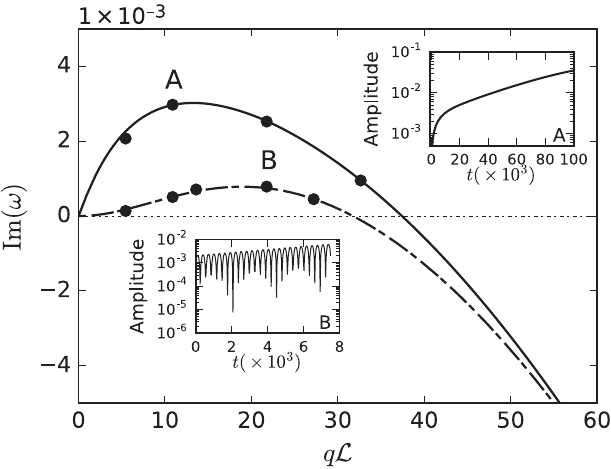
FIG. 3. Comparison of the growth rates obtained from dispersion relation Eq. (11) with those from DNS (black dots). Inset: initial time evolution of the perturbation amplitude j q δ p j for O ð q Þ : R ¼ 10 − 2 (a) and O ð q 2 Þ : R ¼ 4 (b) growth ⊥ × ⊥ q rates (run SPP2). Note that we choose ϕ ¼ 55 ° for the initial